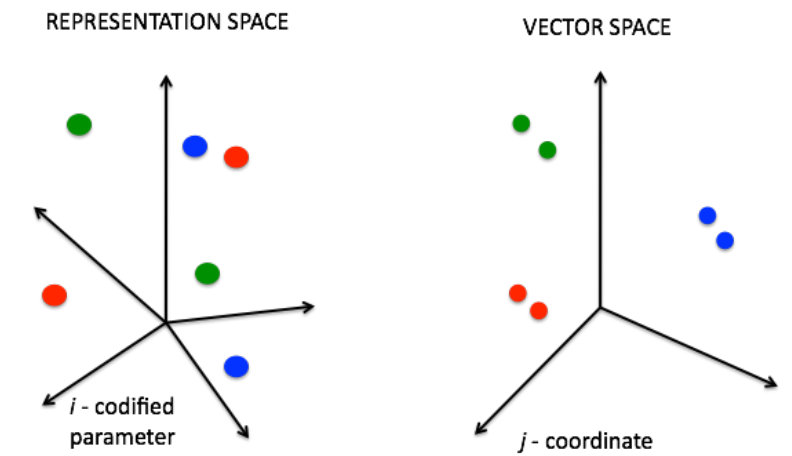
Figure 2. Input space ξ ( left ) and target vector space z ( righ